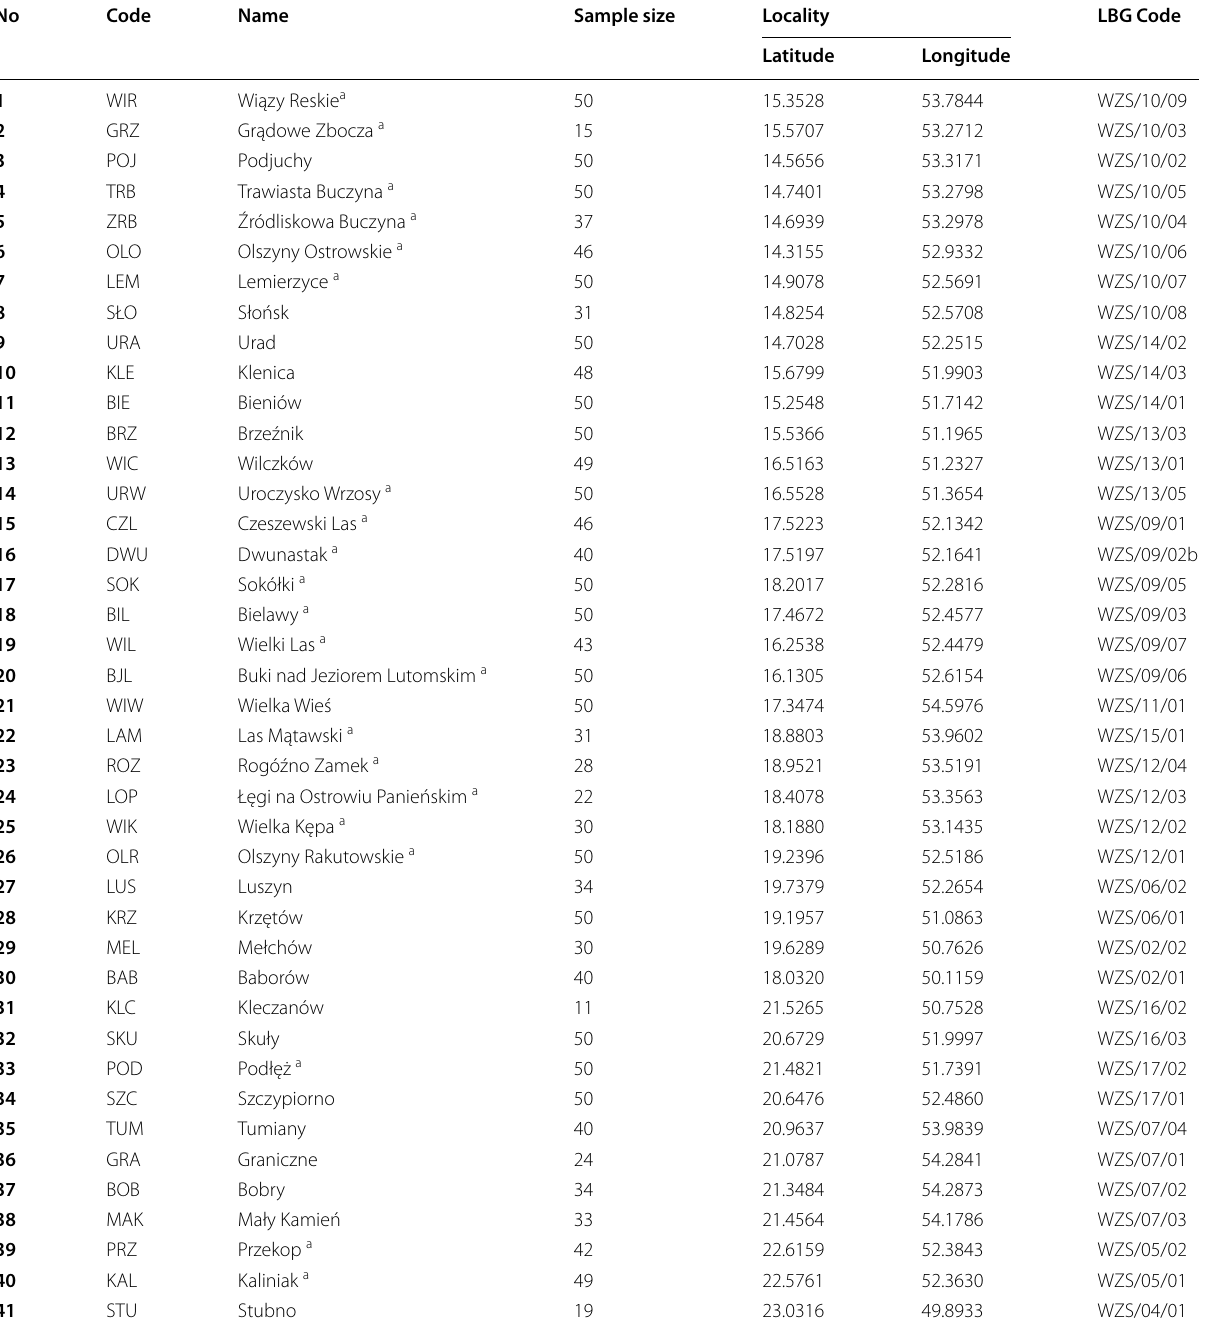
Table 1 Site locations, codes, sample sizes, and LBG code of genetic resources of the U. laevis Pall. populations